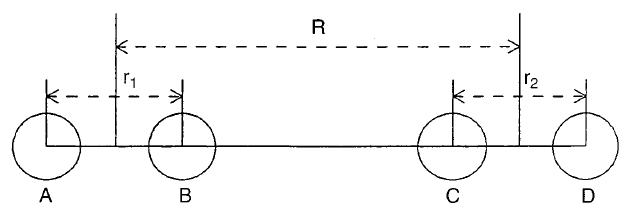
Fig. 2. The collinear collision of the molecules AB